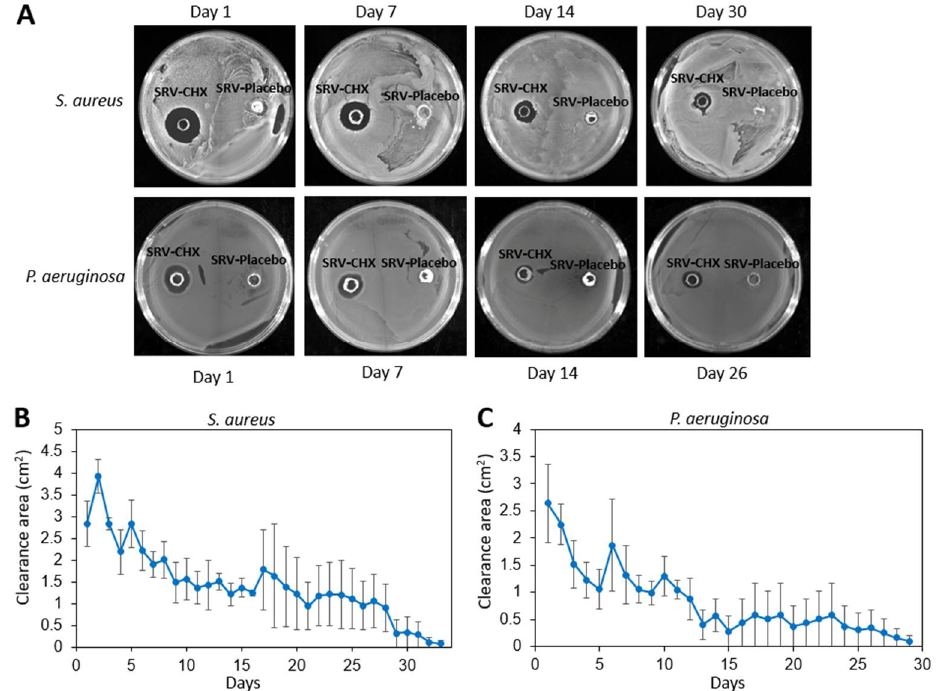
Figure 2. ( A ) Bacterial clearance around SRV-CHX-coated stents plated on fresh S. aureus subsp. aureus ATCC 25923 (upper row) or P. aeruginosa ATCC HER-1018 (PAO1) (lower row) agar plates. The SRV-placebo-coated stents showed no clearance of bacteria. ( B , C ) The average bacterial inhibition zones were observed after daily transfer of SRV-CHX and SRV-placebo-coated stents on fresh S. aureus subsp. aureus ATCC 25923 ( B ) or P. aeruginosa ATCC HER-1018 ( C ) agar plates. n = 3. p < 0.05 for SRV-CHX-coated stents versus SRV-placebo-coated stents.